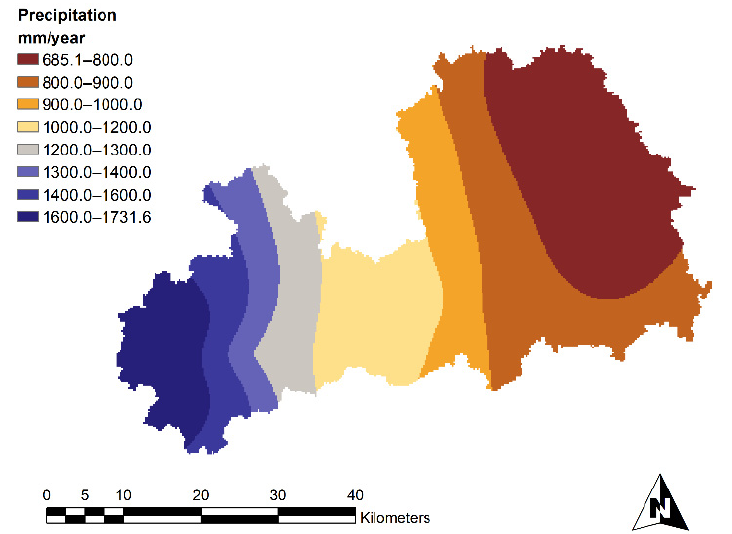
Figure 2. Average annual precipitation in the Dee River basin.